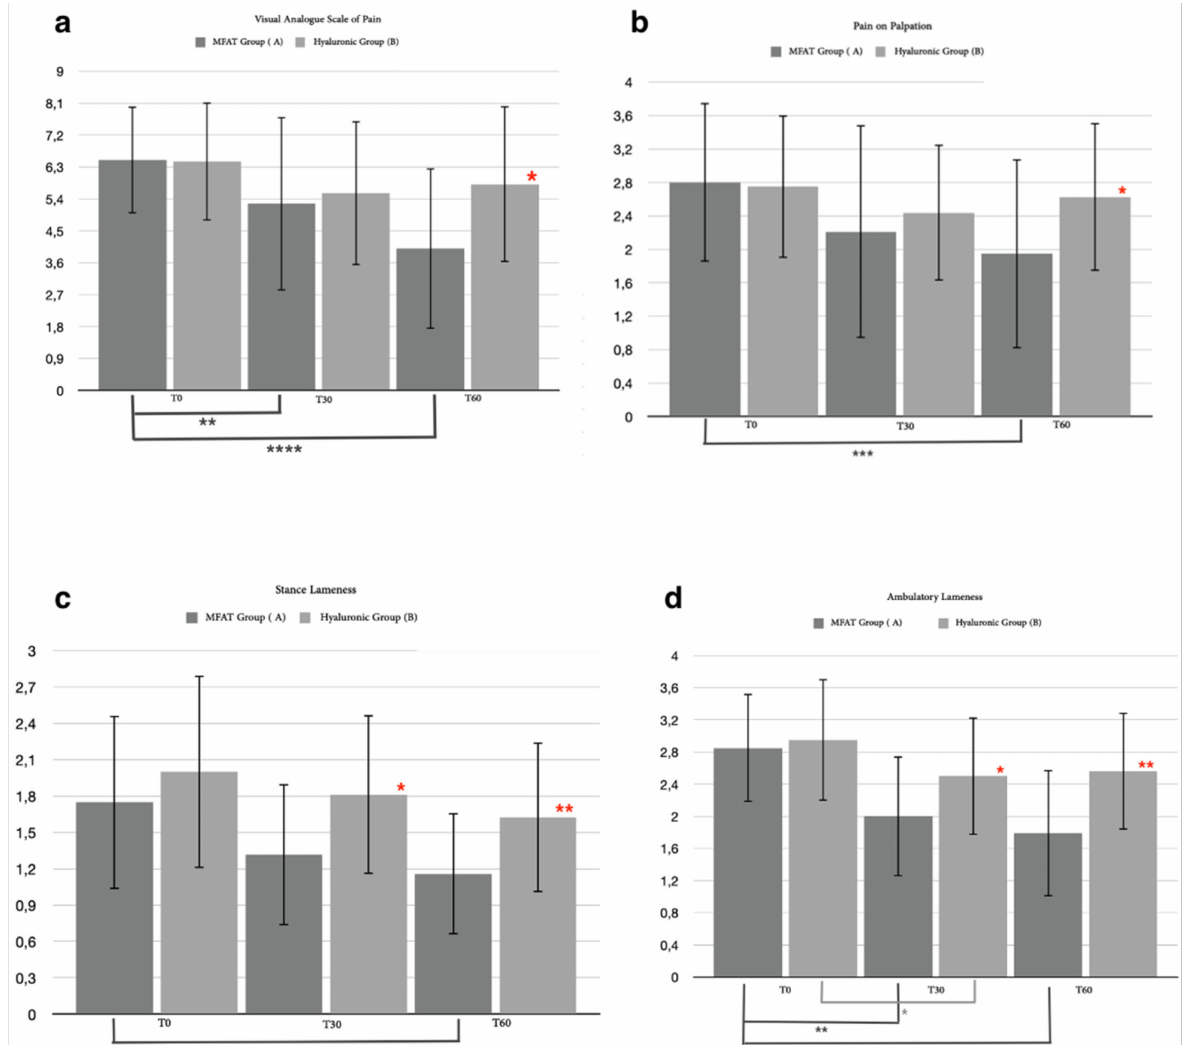
Figure 5. These graphs show the differences in statistical analysis data between hyaluronic group and MFAT group for ( a ) visual analogue score of pain after 30 and after 60 days. Red asterisks (*: p = 0.0149) indicate significant differences between groups, and group-colored asterisks indicate significant differences within each group (**: p = 0.0094; ***: p = 0.0001); ( b ) pain on palpation after 30 and after 60 days. Red asterisks (*: p = 0.0372) indicate strong significant differences between groups, and group-colored asterisks indicate significant differences within each group (***: p = 0.0002); ( c ) stance lameness after 30 and after 60 days. Red asterisks (*: p = 0.0247; **: p = 0.0087) indicate significant differences between groups, and group-colored asterisks indicate significant differences within each group (***: p = 0.0006); and ( d ) ambulatory lameness after 30 days and after 60 days. Red asterisks (*: p = 0.0338; **: p = 0.0037) indicate significant differences between groups, and group-colored asterisks indicate significant differences within each group (*: p = 0.0077; **: p = 0.0027; ***: p =